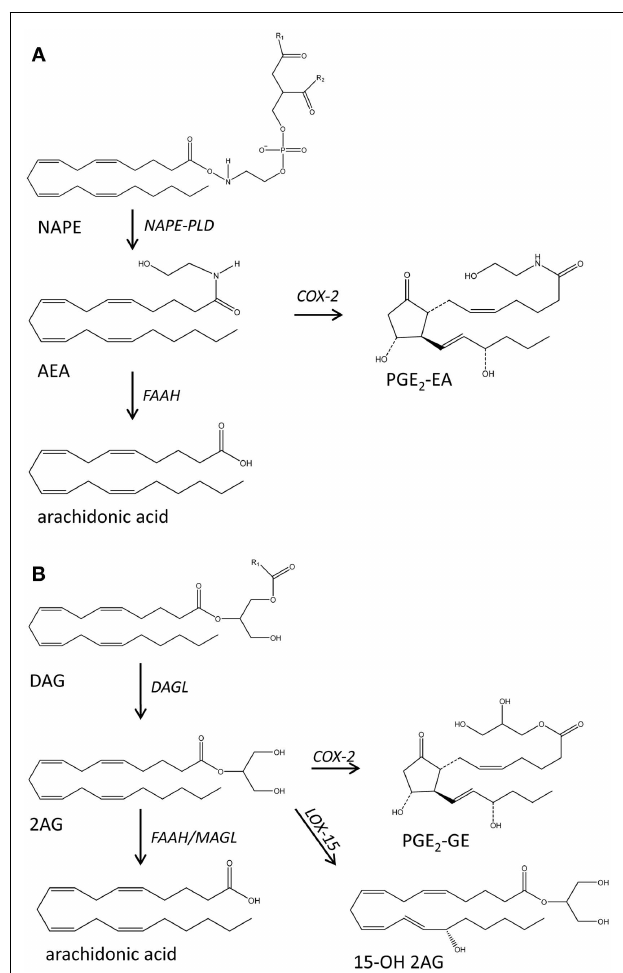
FIGURE 3 | Schematic representation of the main biochemical pathways that mediate the production of endocannabinoids anandamide (AEA) (A) and 2 arachidonoyl glycerol (2-AG) (B) . DAG, diacylglycerol; DAGL, diacylglycerol lipase; FAAH, fatty acid amide hydrolase; 15OH 2AG, 15 hydroxy-2 arachidonoyl glycerol; MAGL, monoacylglycerol lipase; NAPE, N -acylated ethanolamine phospholipids; PGE 2 , PGE 2 ethanolamide; PGE 2 -GE, PGE 2 -glyceryl ester.